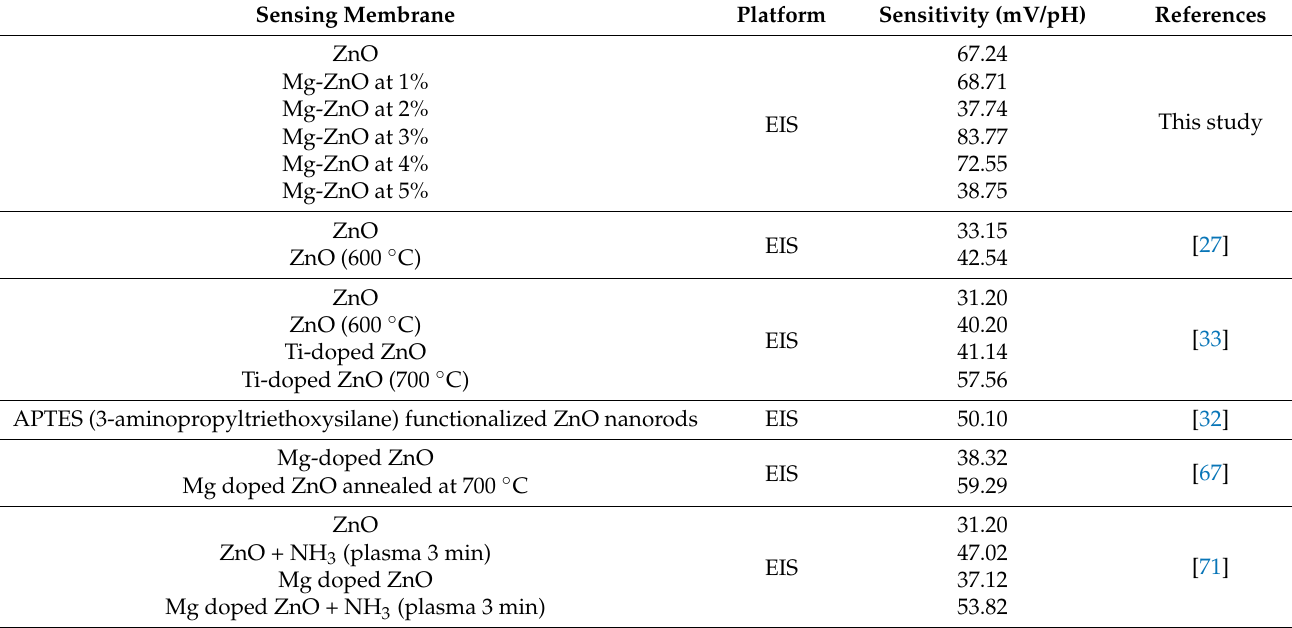
Table 3. Comparison between the results of the fabricated EIS pH sensors based on Mg-doped ZnO nanorod sensing membranes with those of previous